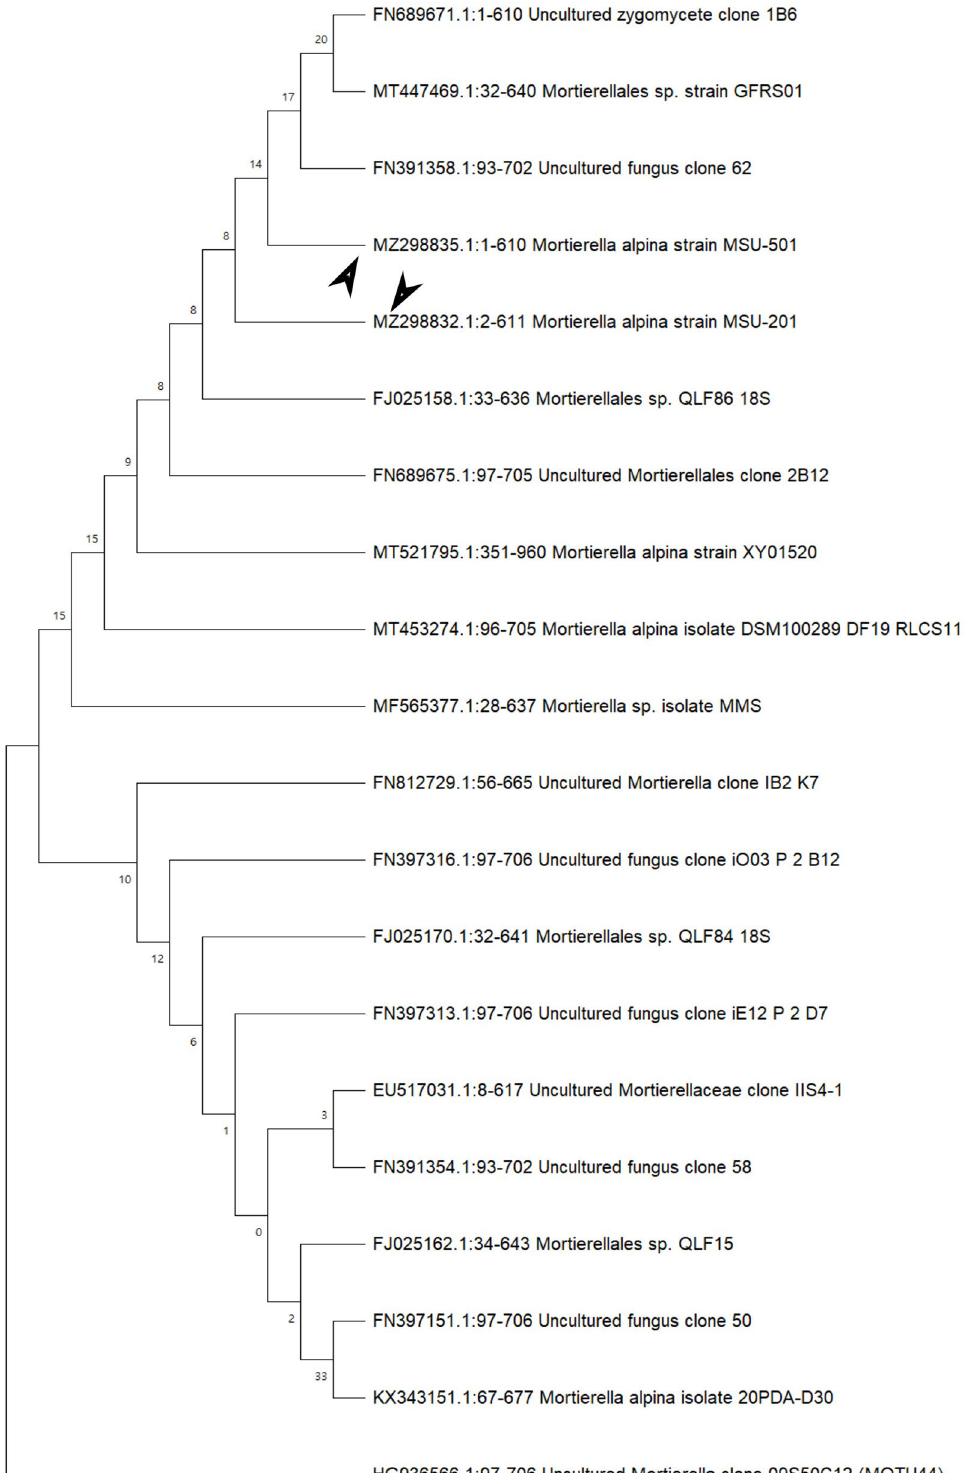
Figure 4. Neighbour joining method based phylogenetic tree from internal transcribed spacer conserved sequences of isolates MSU-201 and MSU-501. Bootstrap support values are indicated at the